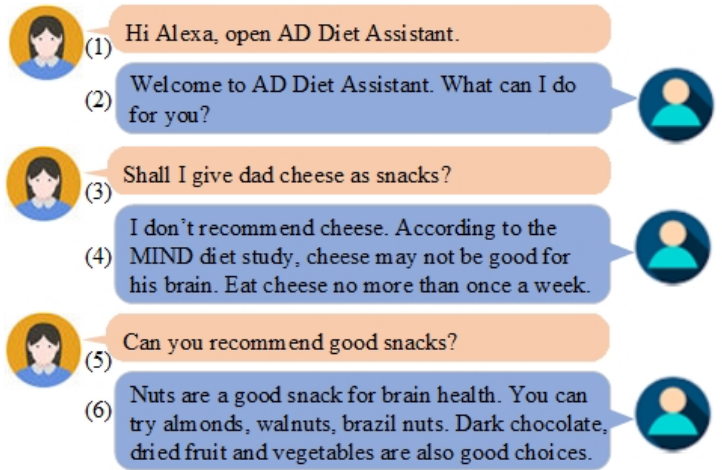
Figure 4. An example of a conversation between the user and the voice assistant about food and nutrition education, and meal suggestion. AD: Alzheimer disease; MIND: Mediterranean–Dietary Approaches to Stop Hypertension Intervention for Neurodegenerative